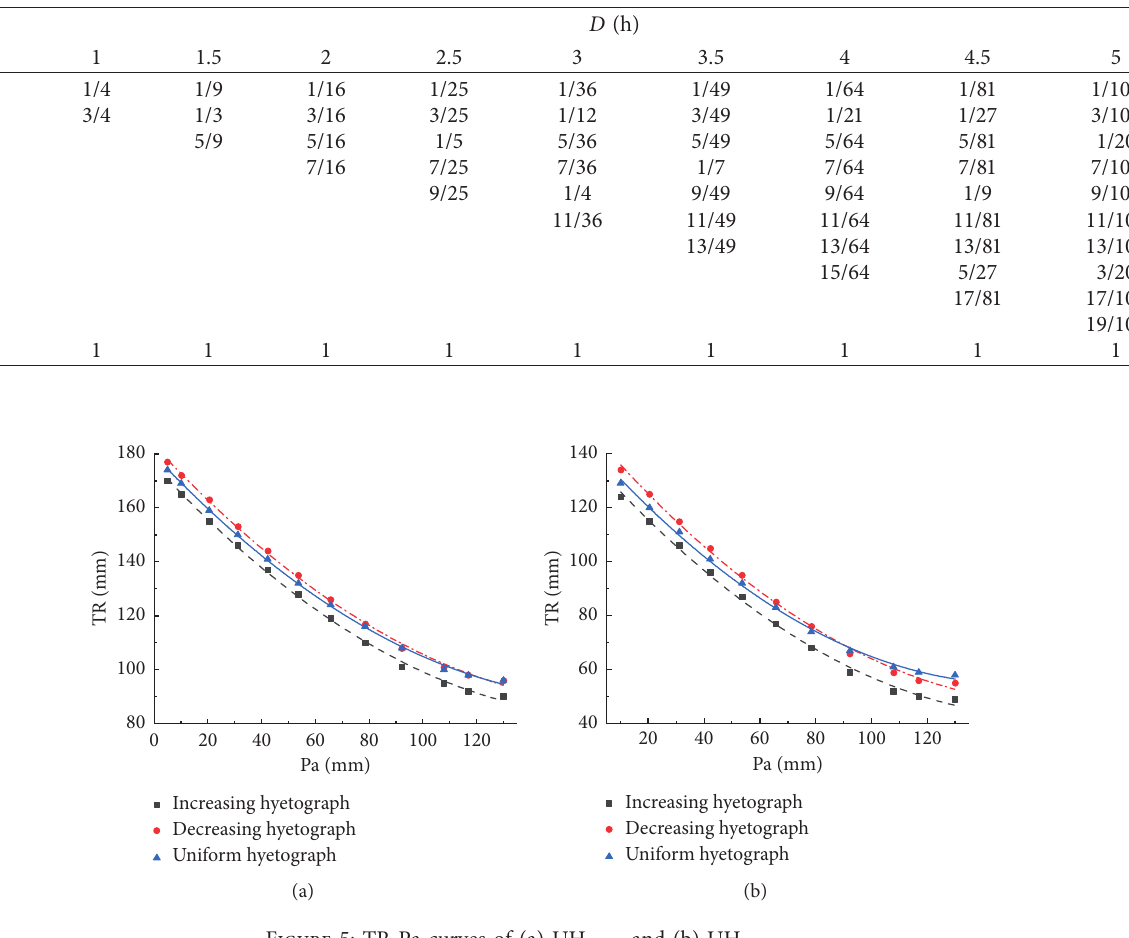
5mm and (b) UH 30mm